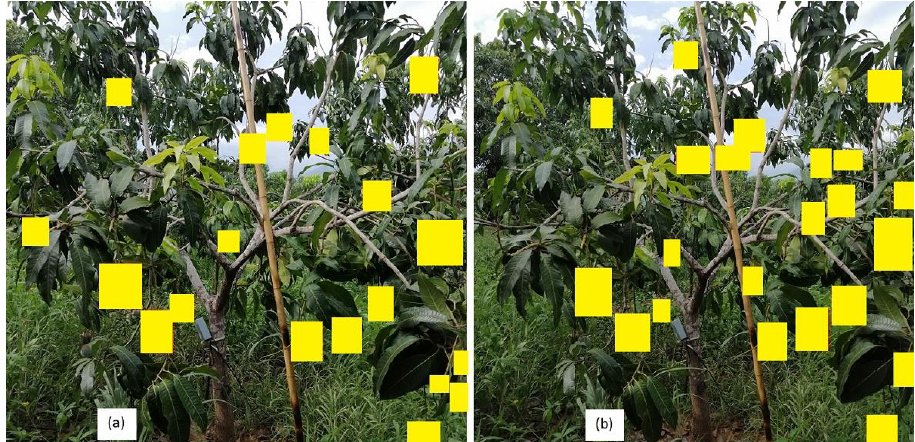
Figure 16. Counting mango fruits from the ( a ) front and ( b ) back of HD trees.